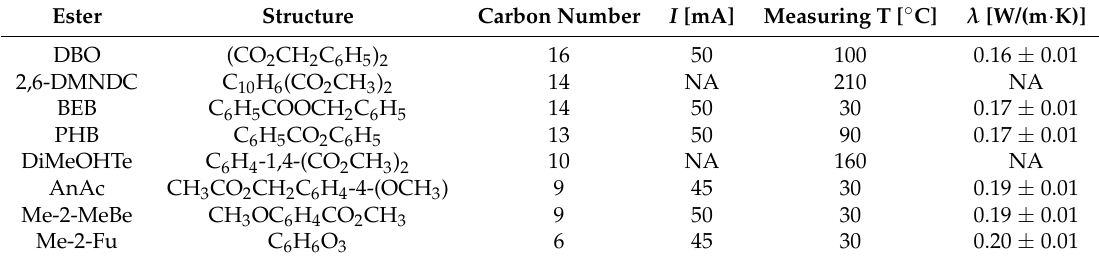
Table 4. Summary of the thermal conductivities λ (W/(m · K)) measured for the aromatic esters presented. For each ester, the chemical structure and carbon numbers are indicated alongside the current I (mA) and temperature T ( ◦ C) at which the measurements were performed. The λ of the aromatic esters for which the measurement could not be performed are indicated as Not Available (NA). No significant trends could be observed, and, in general, the λ are found to be in the same range as other organic compounds, such as